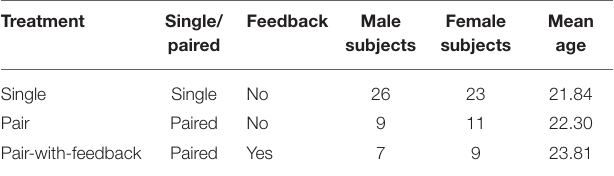
TABLE 1 | Experimental design and number of